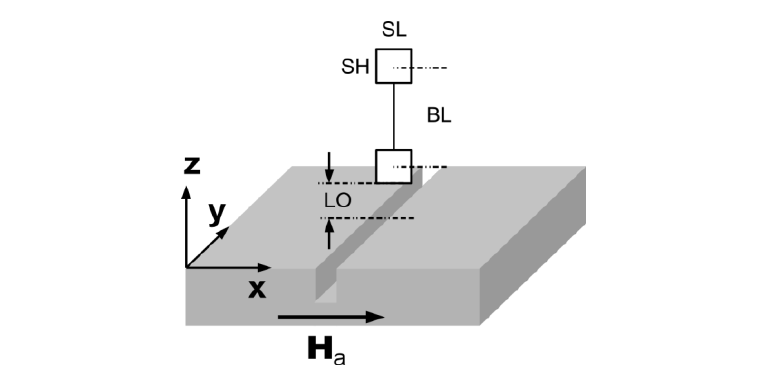
Figure 3. Parameters characterizing the dimensions of the gradiometer and its elements and the distance between sensor and surface ( LO = lift off). The sensor area is SH × SL . The base line BL denotes the distance between the two centers of the active sensing layers.